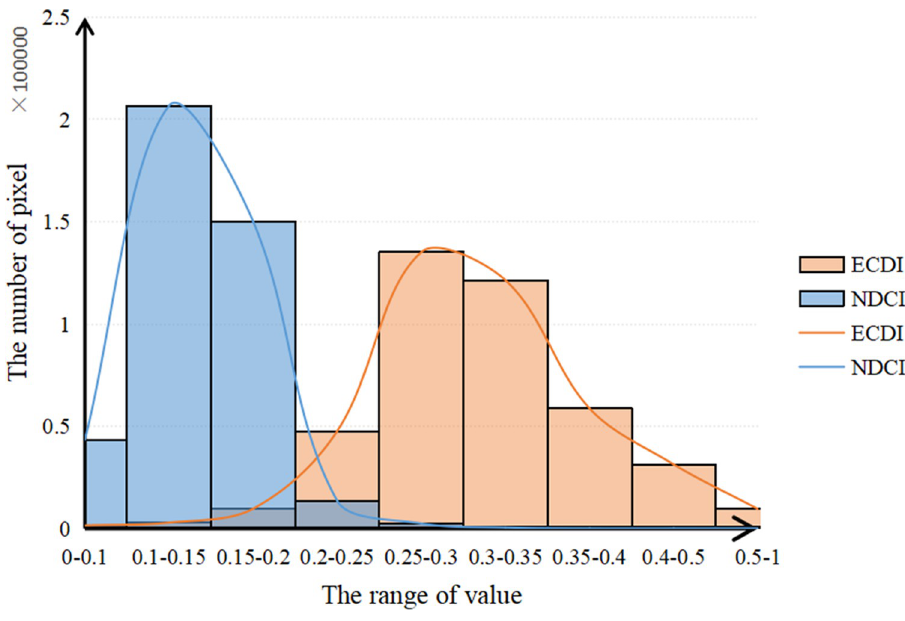
Fig 5. Value ranges of the NDCI and